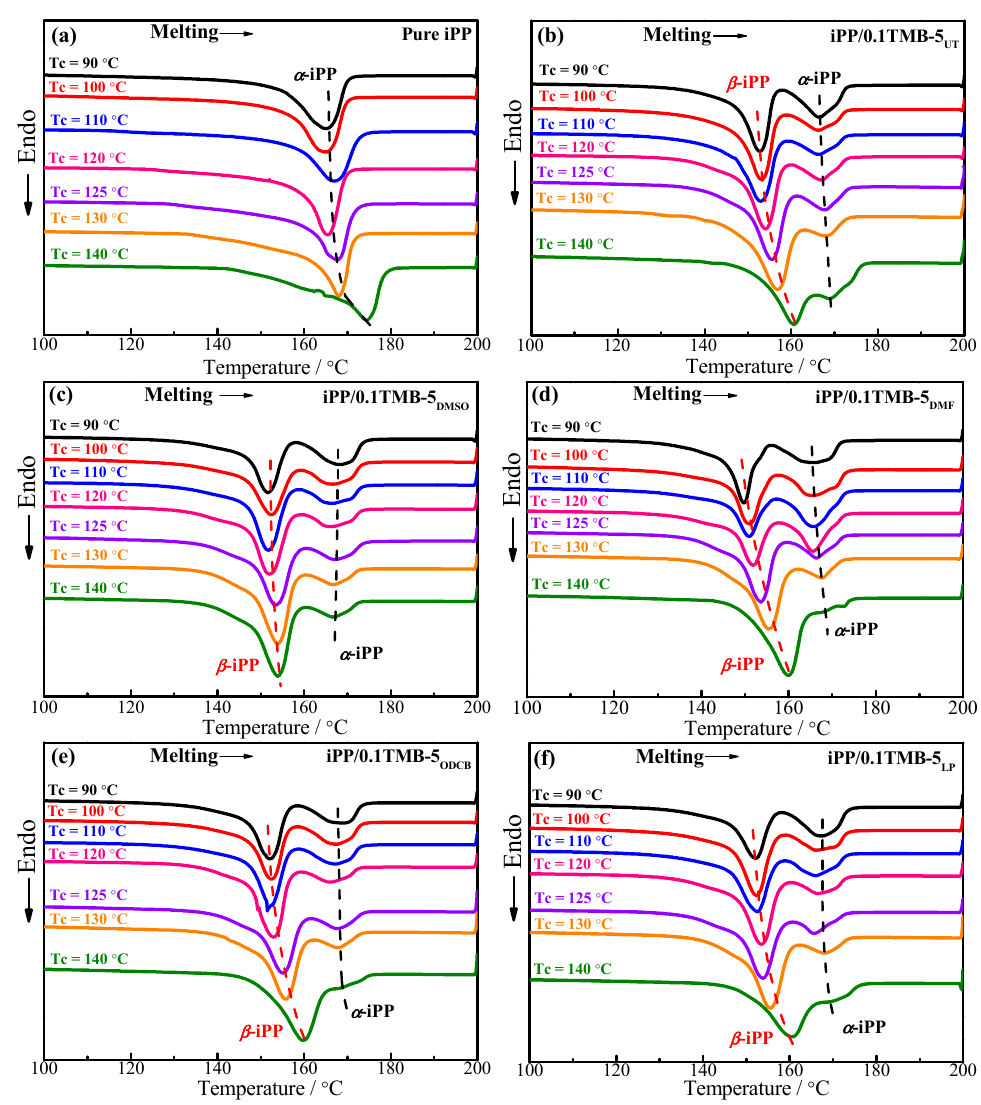
Figure 6. Dependence of melting behaviors of crystallized ( a ) pure iPP, ( b ) iPP/0.1TMB-5 UT , ( c ) iPP/0.1TMB-5 DMSO , ( d ) iPP/0.1TMB-5 DMF , ( e ) iPP/0.1TMB-5 ODCB and ( f ) iPP/0.1TMB-5 LP on the